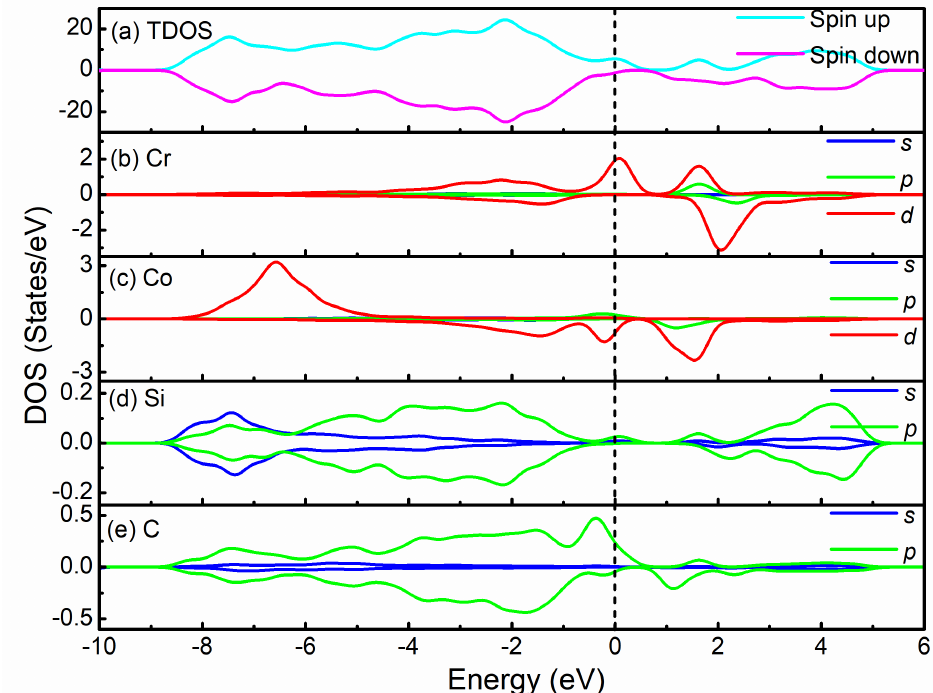
Figure 4. ( a – e ) Total and partial density of states of (0, 10) configuration (Cr, Co)-codoped 4H–SiC. The Fermi level is set to 0